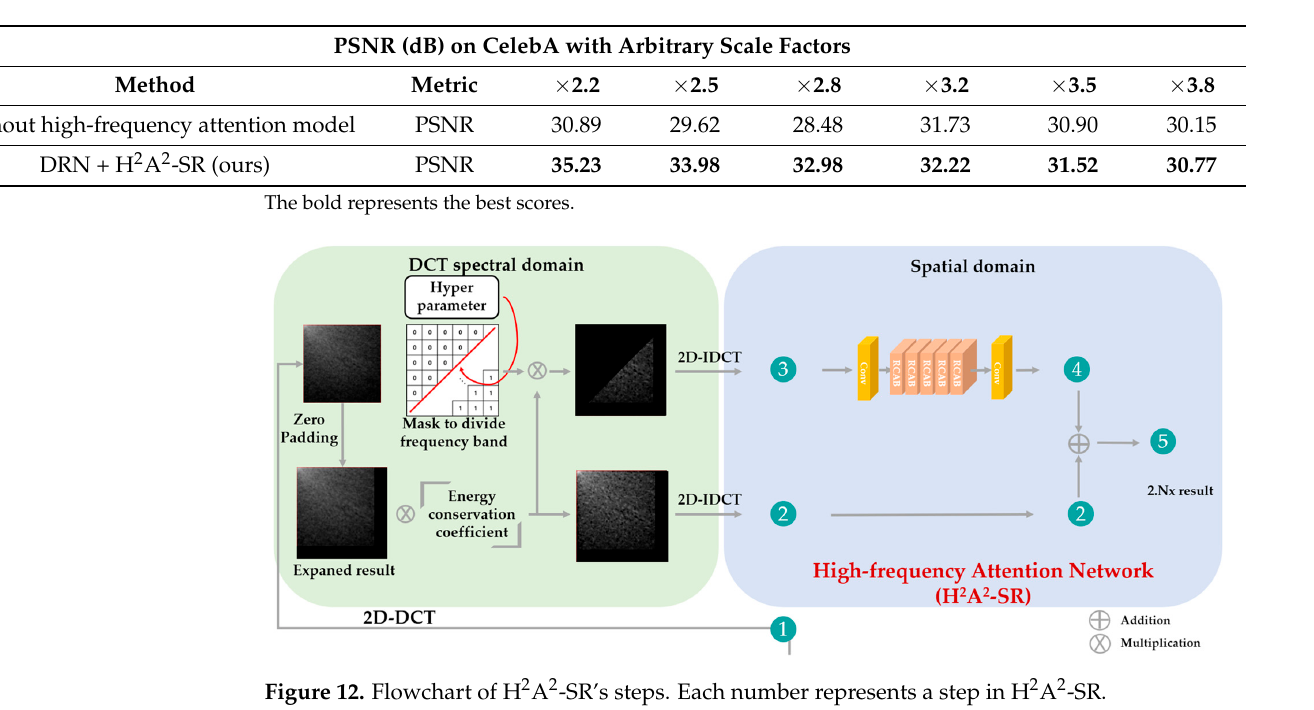
Table 6. Quantitative comparison between our H 2 A 2 -SR with and without high-frequency attention model.